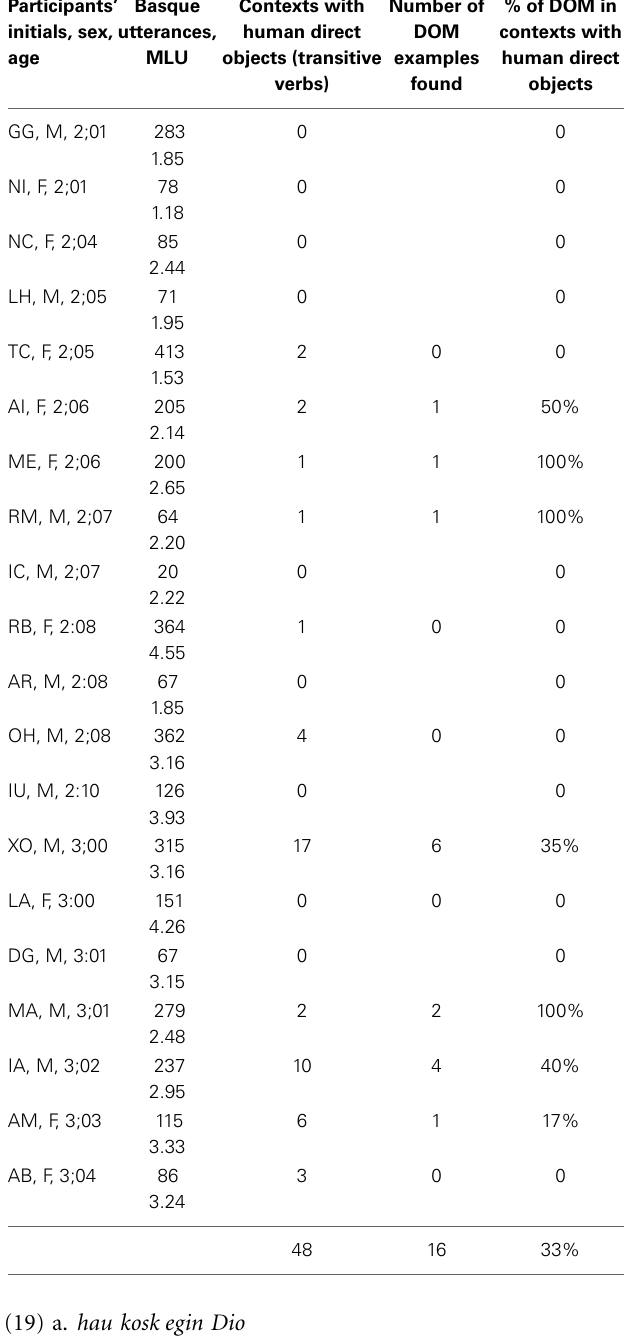
Table 6 | Verbs used with DOM by adults (Austin, 2006). Verbs used with DOM